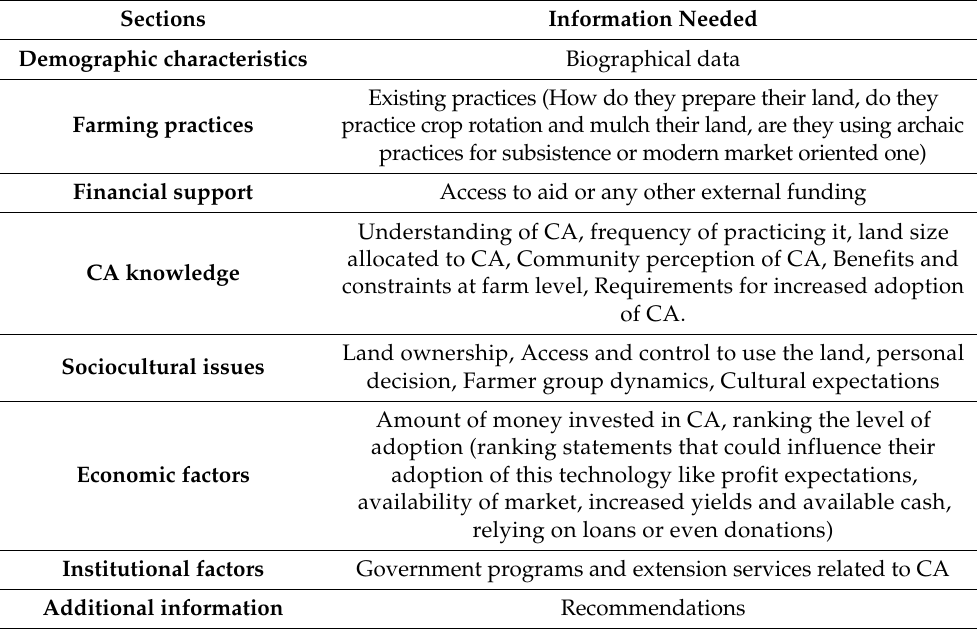
Table 2. Description of the structure of the questionnaire (interview) and the information needed.